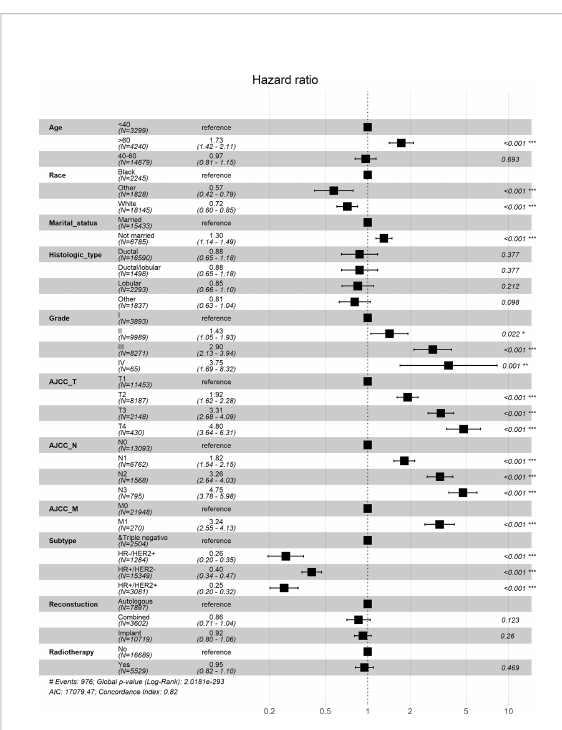
FIGURE 7 Forest map visualizing Cox multivariate regression of breast cancer-